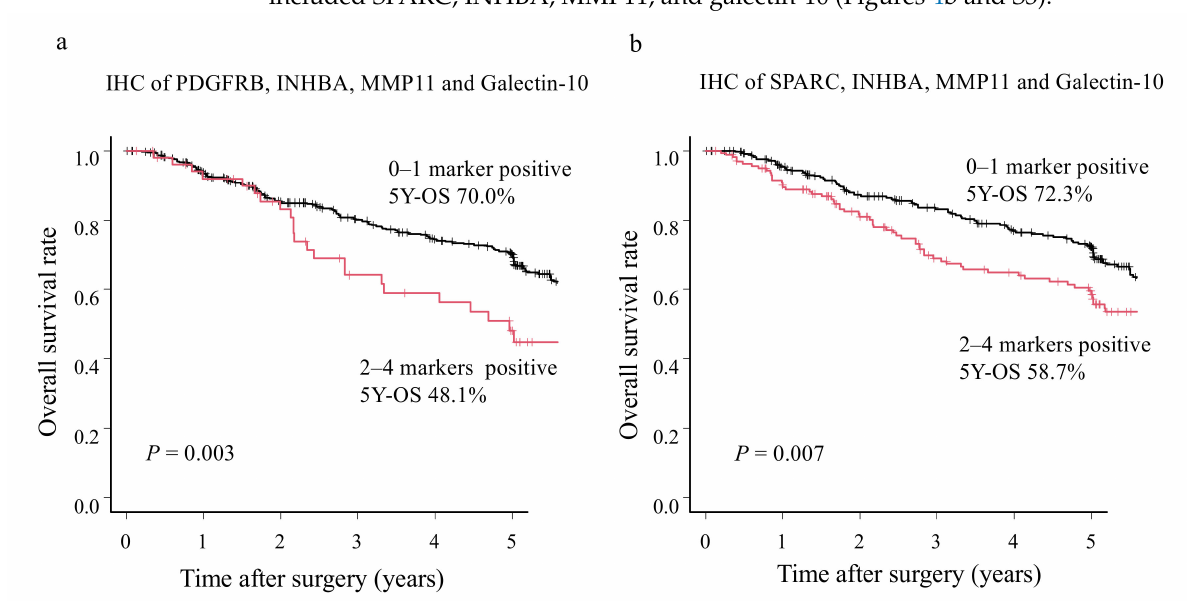
(Table 5). Postoperative survival prediction in pStage II/III GC tissue was observed to be superior when expression of this combination of biomarkers was considered together as compared to galectin-10 expression alone. The second-best biomarker combination marker included SPARC, INHBA, MMP11, and galectin-10 (Figures 4b and S3).